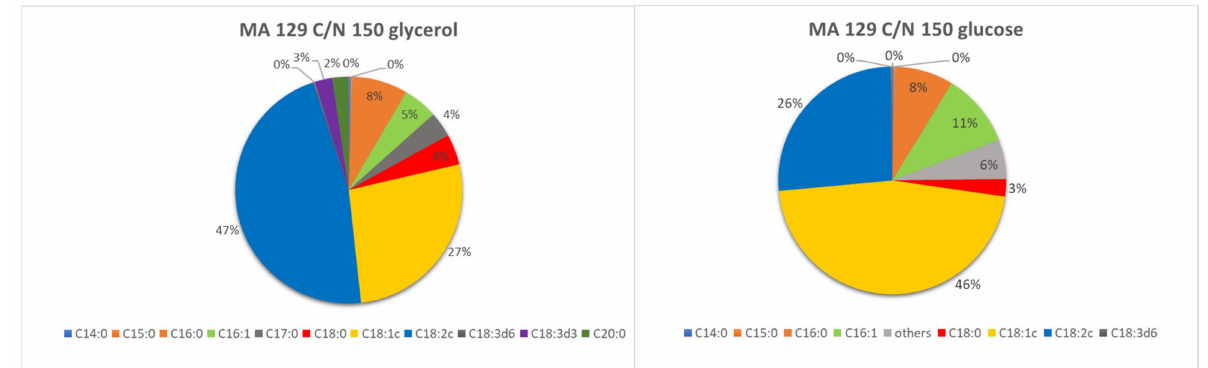
Figure 3. Fatty acid profile of M. andauensis 129 (MA 129) cultivated at C/N ratio 150 on various carbon sources at cold